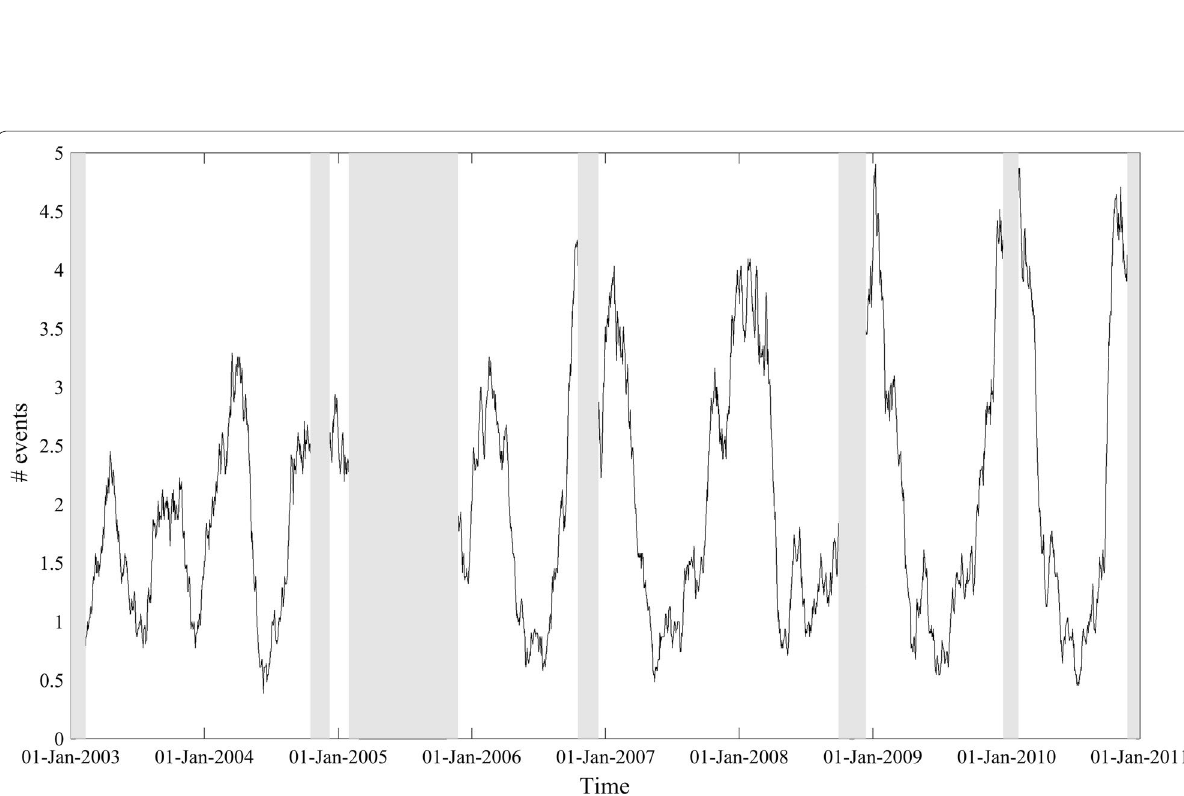
Fig. 5 Occurrence of ULF events from 2003 to 2010. The number of events per day for different years. Shaded areas represent data